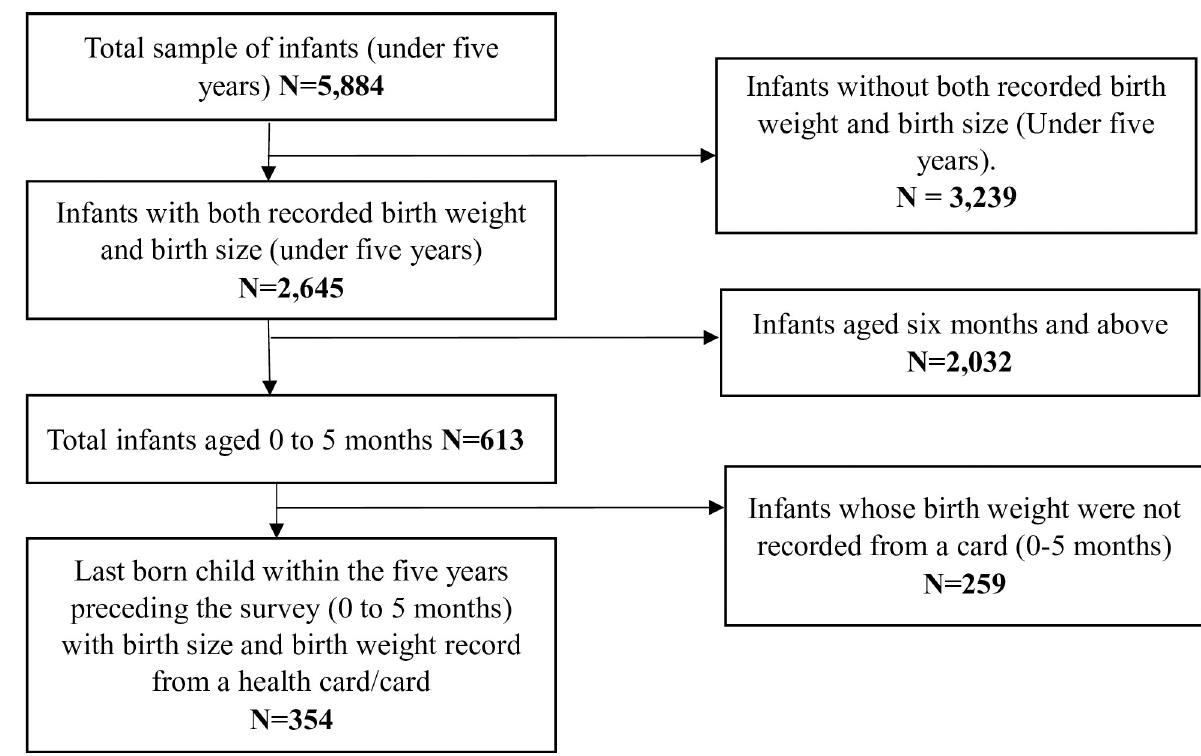
Fig 1. Schematic diagram showing how infants were selected from the GDHS for the